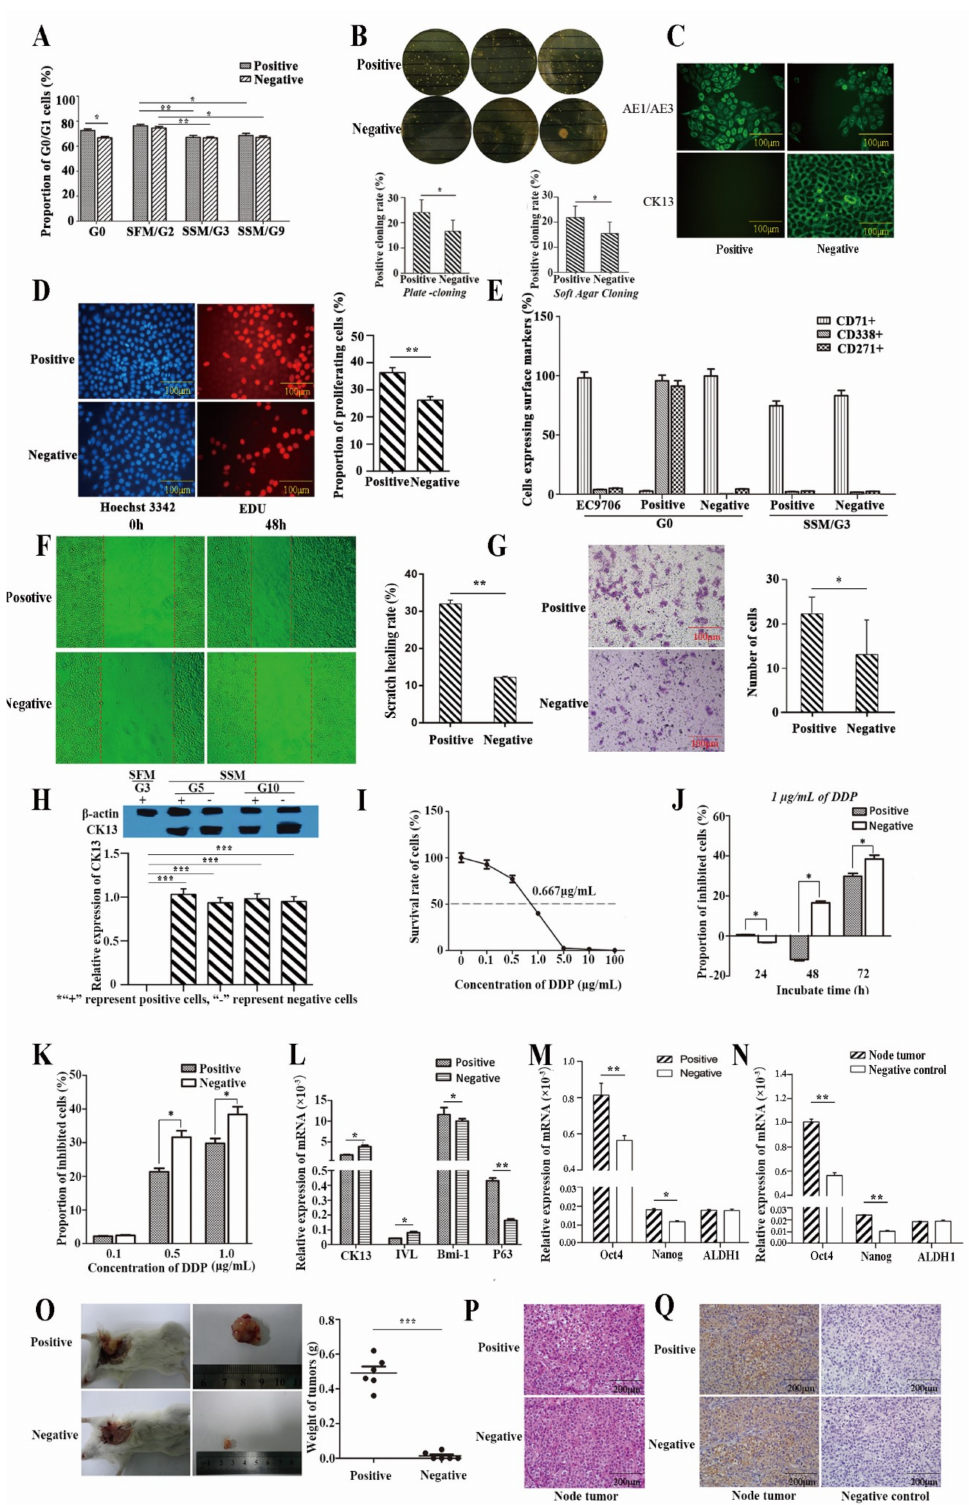
Figure 3. CD71 − / CD271 + / CD338 + subpopulations of cells possessed more stem cell properties. ( A ) Cell cycle analysis of the two subpopulations of cells using flow cytometry. ( B ) Self-renewal ability was detected by plate-cloning and soft agar-cloning experiments. ( C ) Immunofluorescence analysis of Cytokeratin AE1 / AE3 and CK13 in two subpopulations of cells when cultured for three generations. ( D ) Proliferation of two subpopulations of cells when cultured in SSM and SFM. ( E ) Expression of CD271, CD71, and CD338 in di ff erent subpopulations of cells. ( F ) Migration ability of two subpopulations of cells detected by scratch-healing experiments. ( G ) Result of invasiveness detected by a Transwell assay. ( H ) The expression of CK13 detected by Western blot. ( I ) Half maximal inhibitory concentration